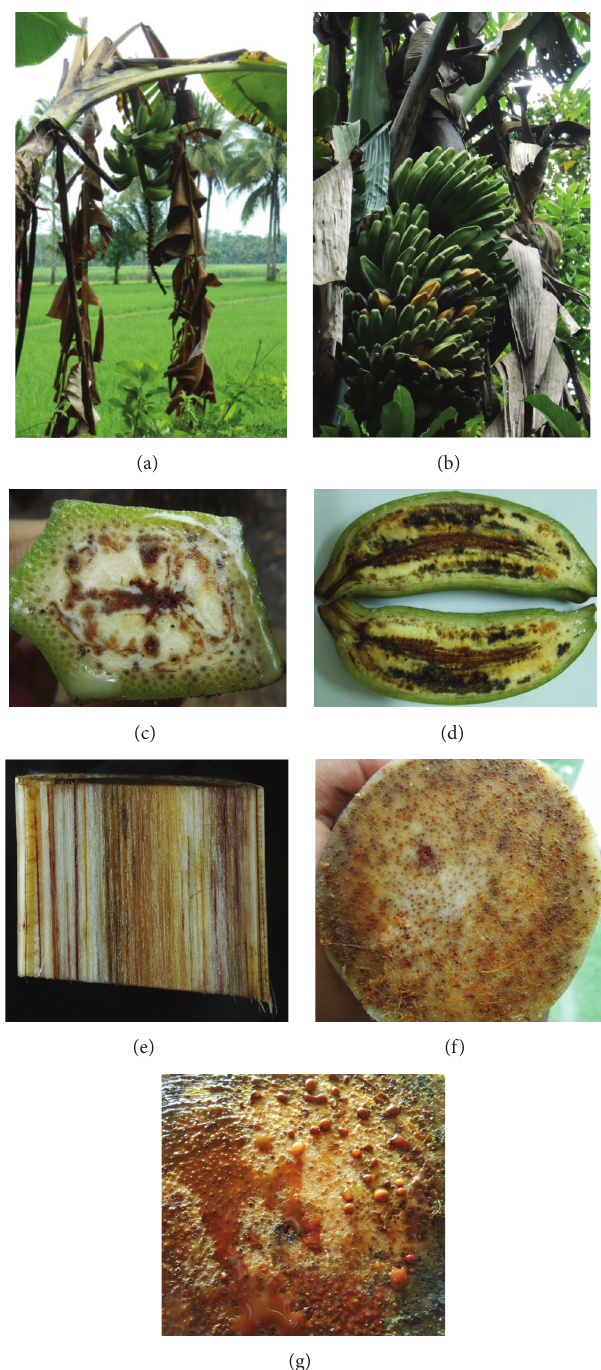
Figure 2: Wilt symptom on banana trees (a), bunches (b), fruits that are horizontally sliced (c), fruits that are vertically sliced (d), stems that are vertically sliced (e), stems that are horizontally sliced (f), and bacterial mass/ooze on the stem slice surface